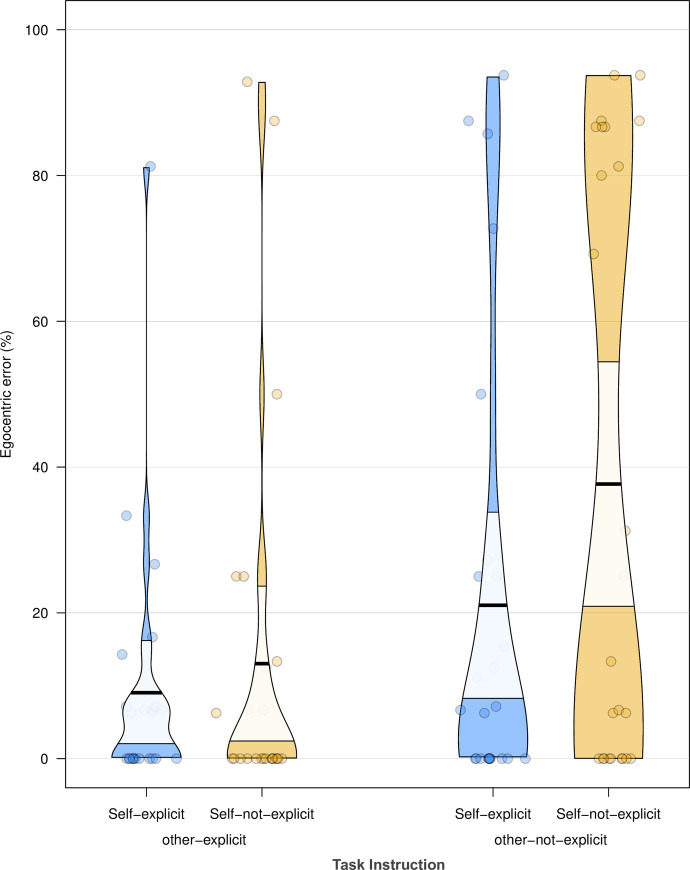
Pirate plot for the percentage egocentric errors from Experiment 2.Each circle represents the mean percentage egocentric error for a participant. The bold horizontal lines correspond to the condition means, the light-coloured bands around the means correspond to the confidence intervals.